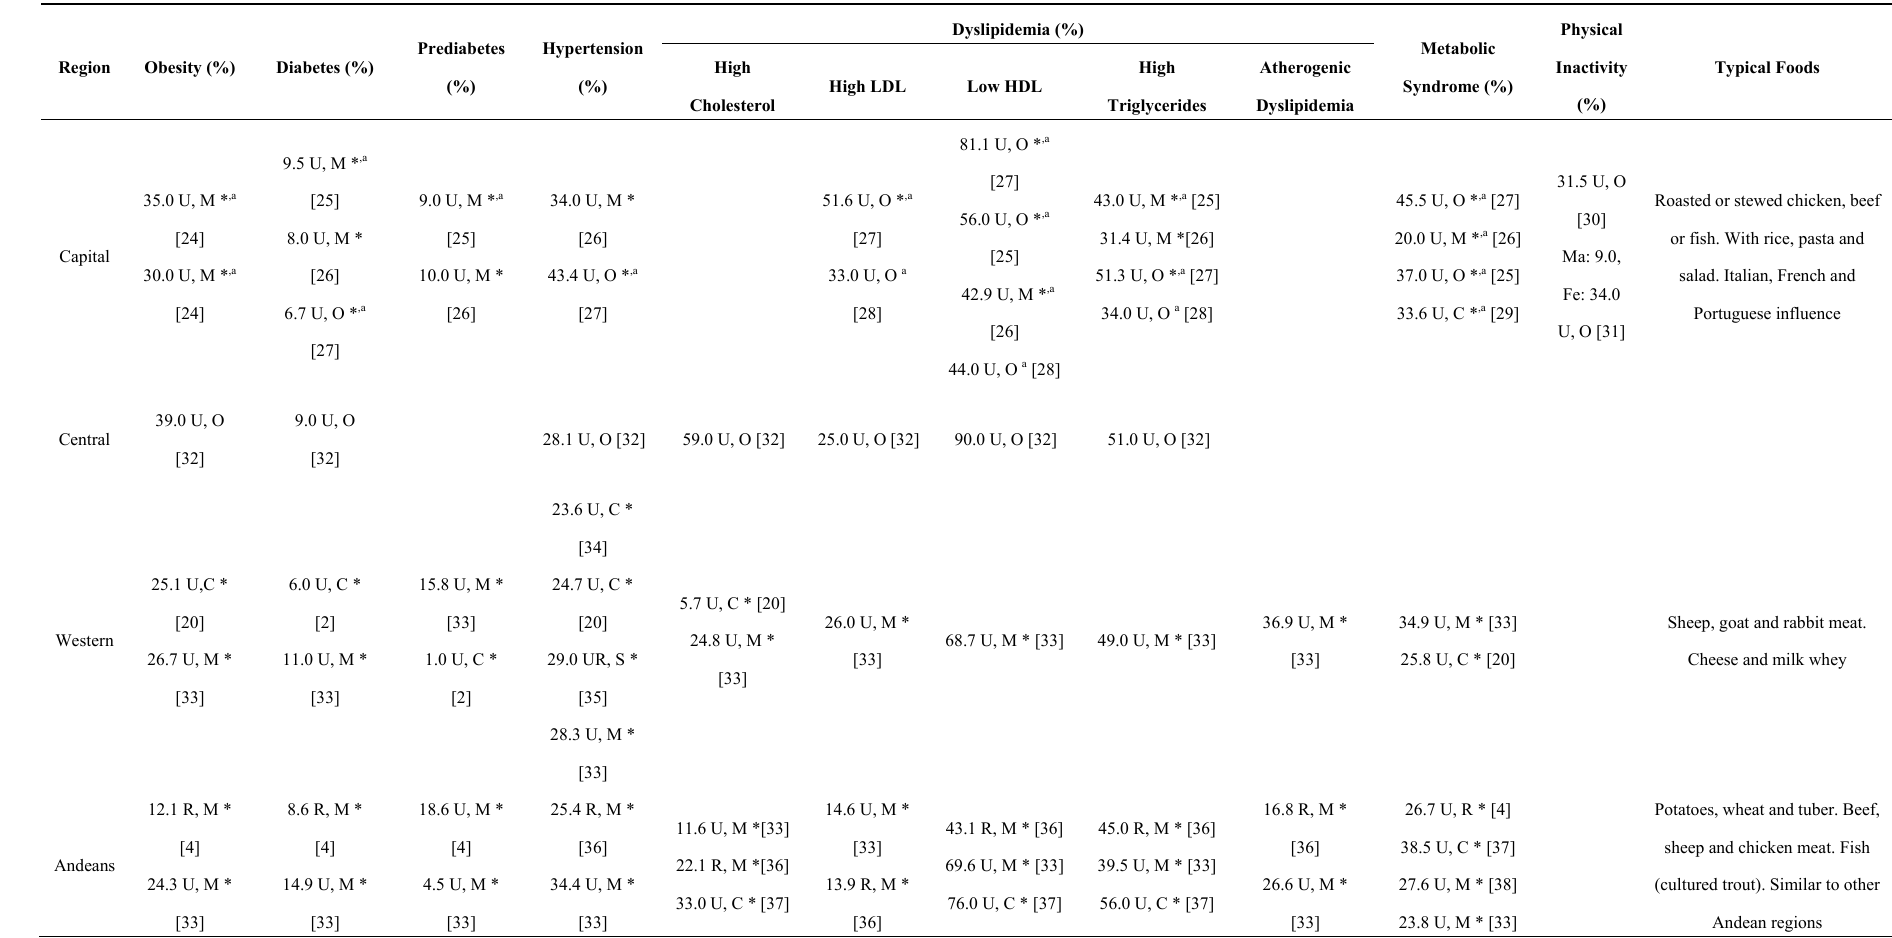
Table 1. Prevalence of adult cardio-metabolic components in eight regions of